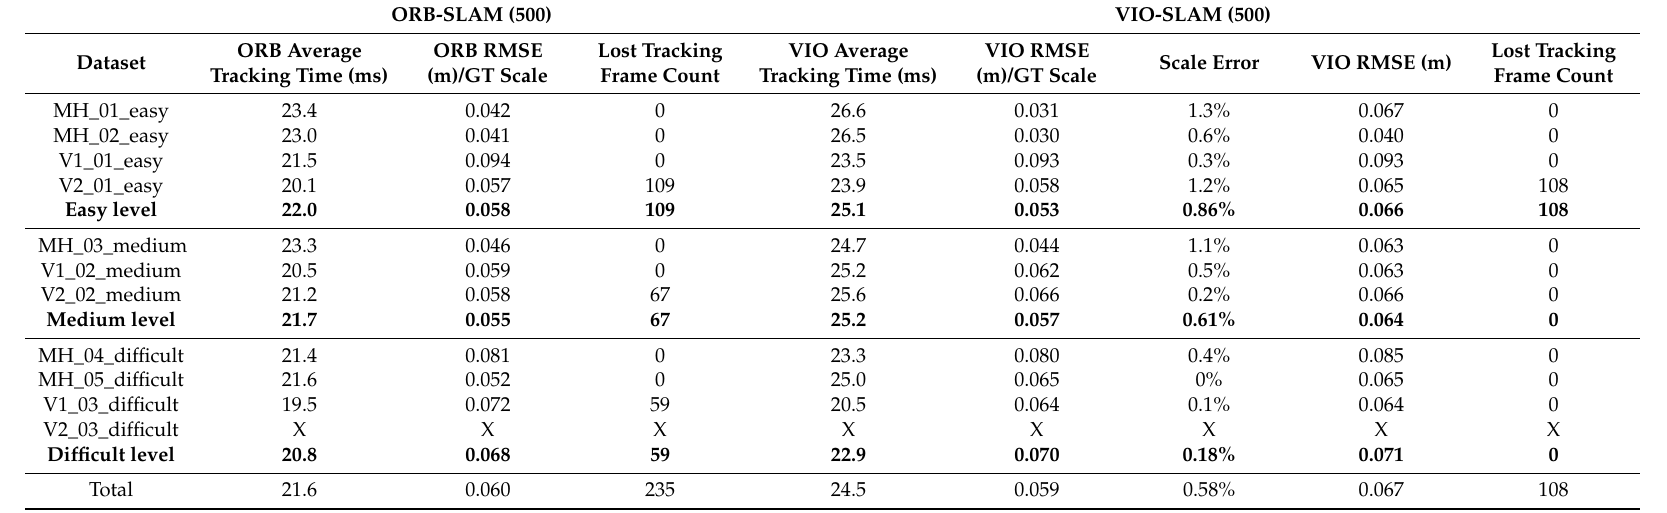
Table 5. Evaluation of VIO-based SLAM and comparison with the monocular